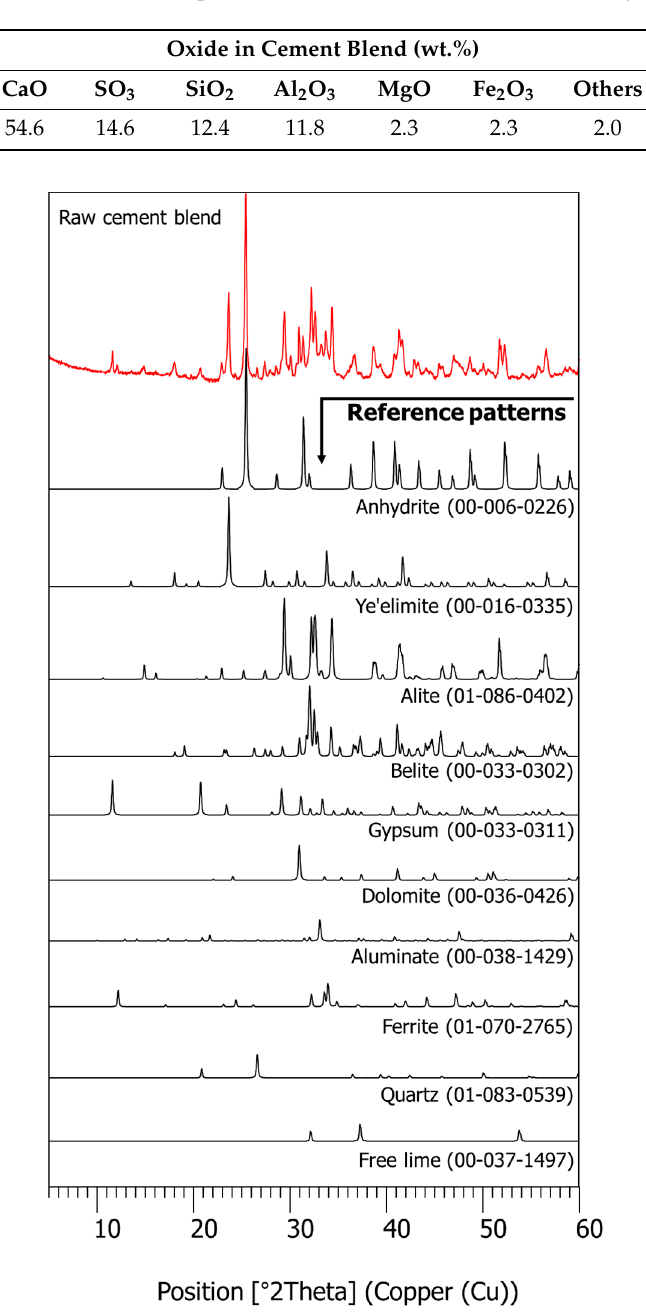
Figure 2. The XRD pattern of the raw cement blend.